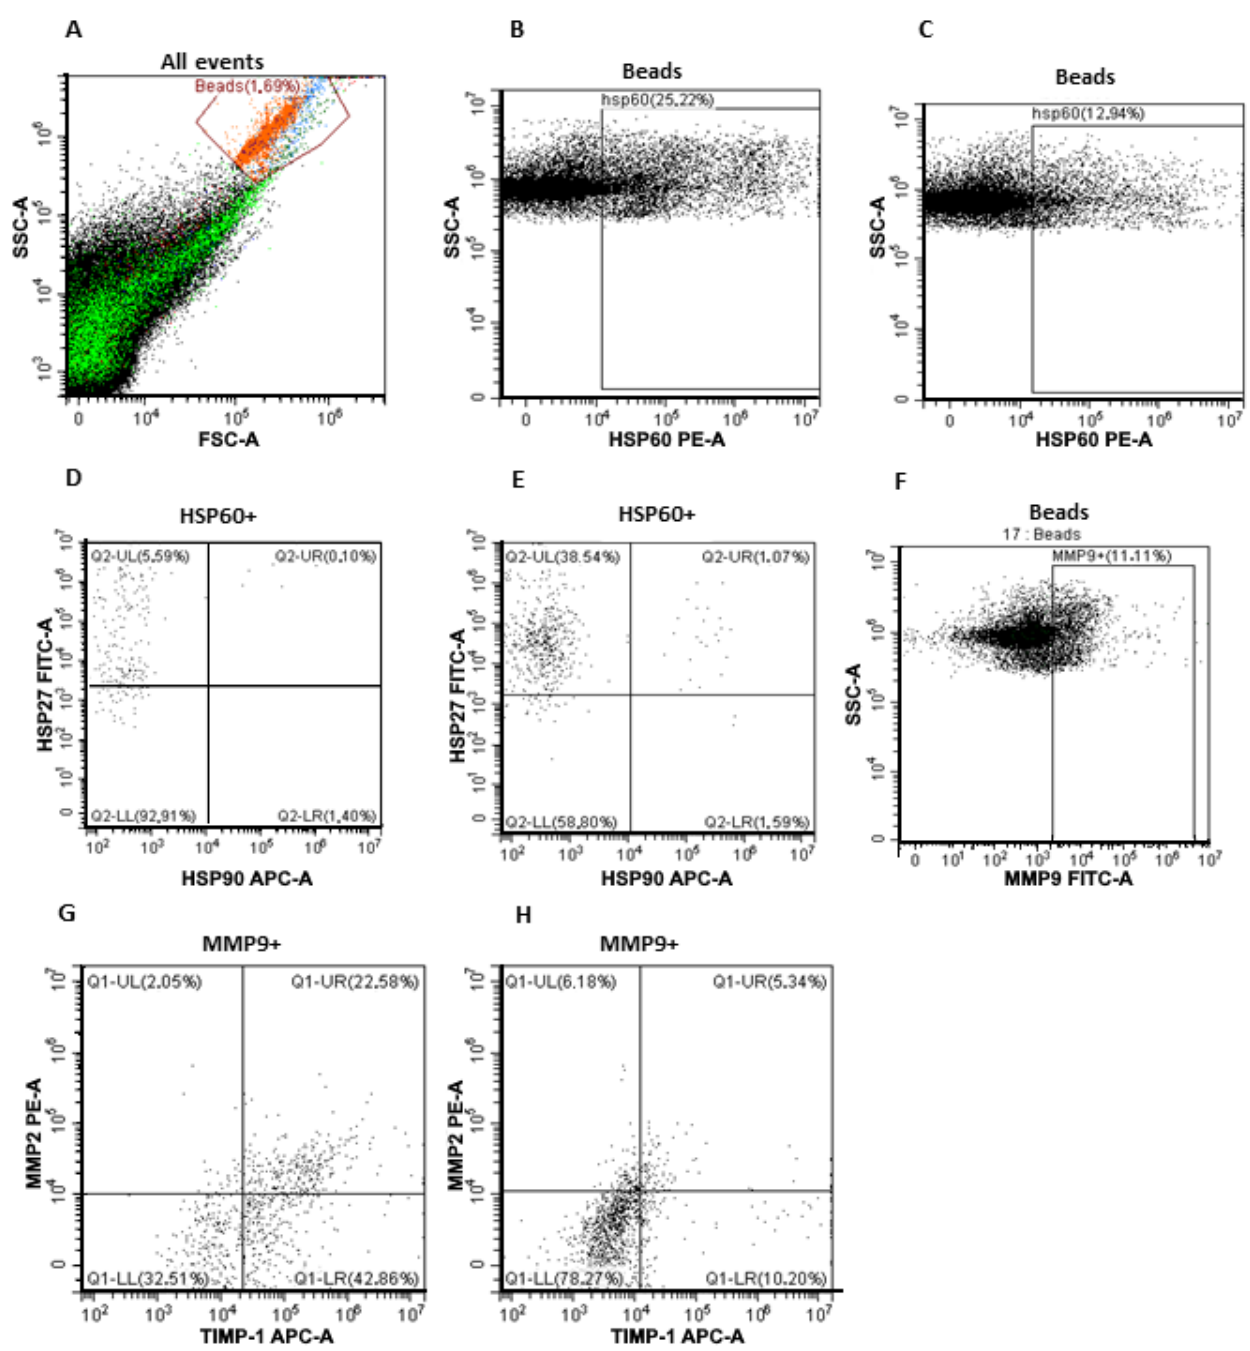
Figure 2. Flow cytometry of blood plasma sEVs. ( A ) Forward scatter area (FSC - A) versus side scatter area (SSC - A) dot plot representing sEV samples adsorbed on aldehyde–sulfate latex beads labeled anti - CD9 or anti - FABP4 antibodies; ( B ) HSP60 - positive sEVs within CD9 - positive sEVs in CPPs and ( C ) CRCPs; ( D ) triple - labeling with antibodies against HSP60, HSP27, and HSP90 of plasma CD9 - positive sEVs of CPPs and ( E ) CRCPs; ( F ) MMP9 - positive population within FABP4 - positive sEVs in CRCPs; ( G ) triple - labeling with antibodies against MMP9, MMP2, and TIMP1 of blood plasma FABP4 - positive sEVs of CRCPs and ( H ) CPPs. The results presented are consistent with our earlier data on the preferential expression of MMP9 on the surface of CD9 - positive sEVs compared with MMP2 and TIMP1 in healthy women, patients with borderline ovarian tumors, and patients with ovarian cancer, and MMP9 - positive exosomes were more frequently found in CRCPs